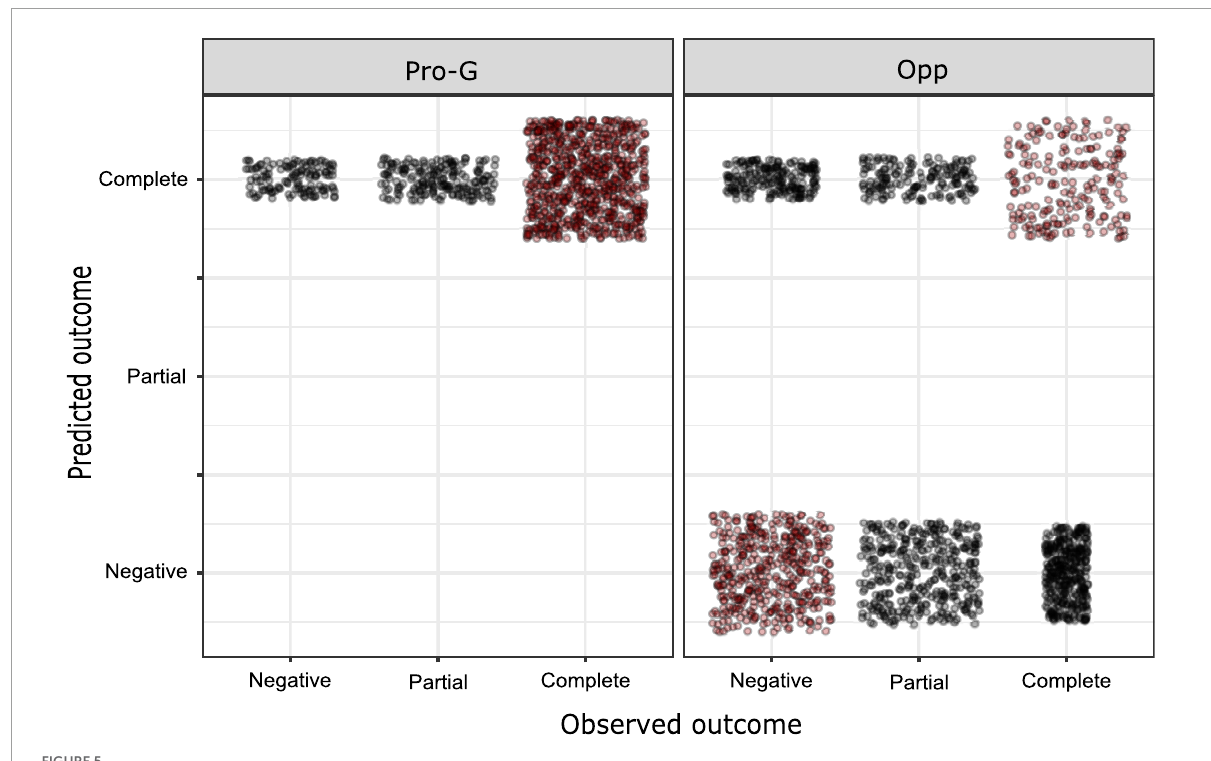
FIGURE5 Predicted vs. observed outcomes in ordinal regression. Red dots correspond to matched cases (Pro-G, government supporters; Opp, opposition supporters).